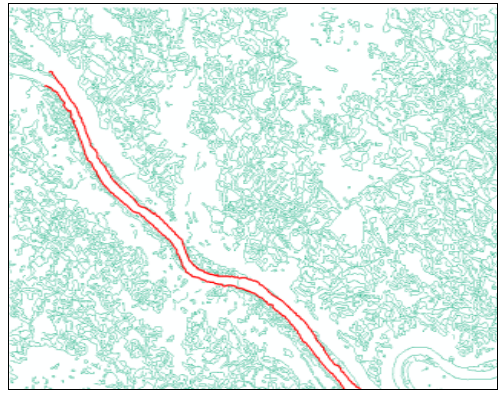
Figure 3. Detected edges in vector format; the red line is the line of interest